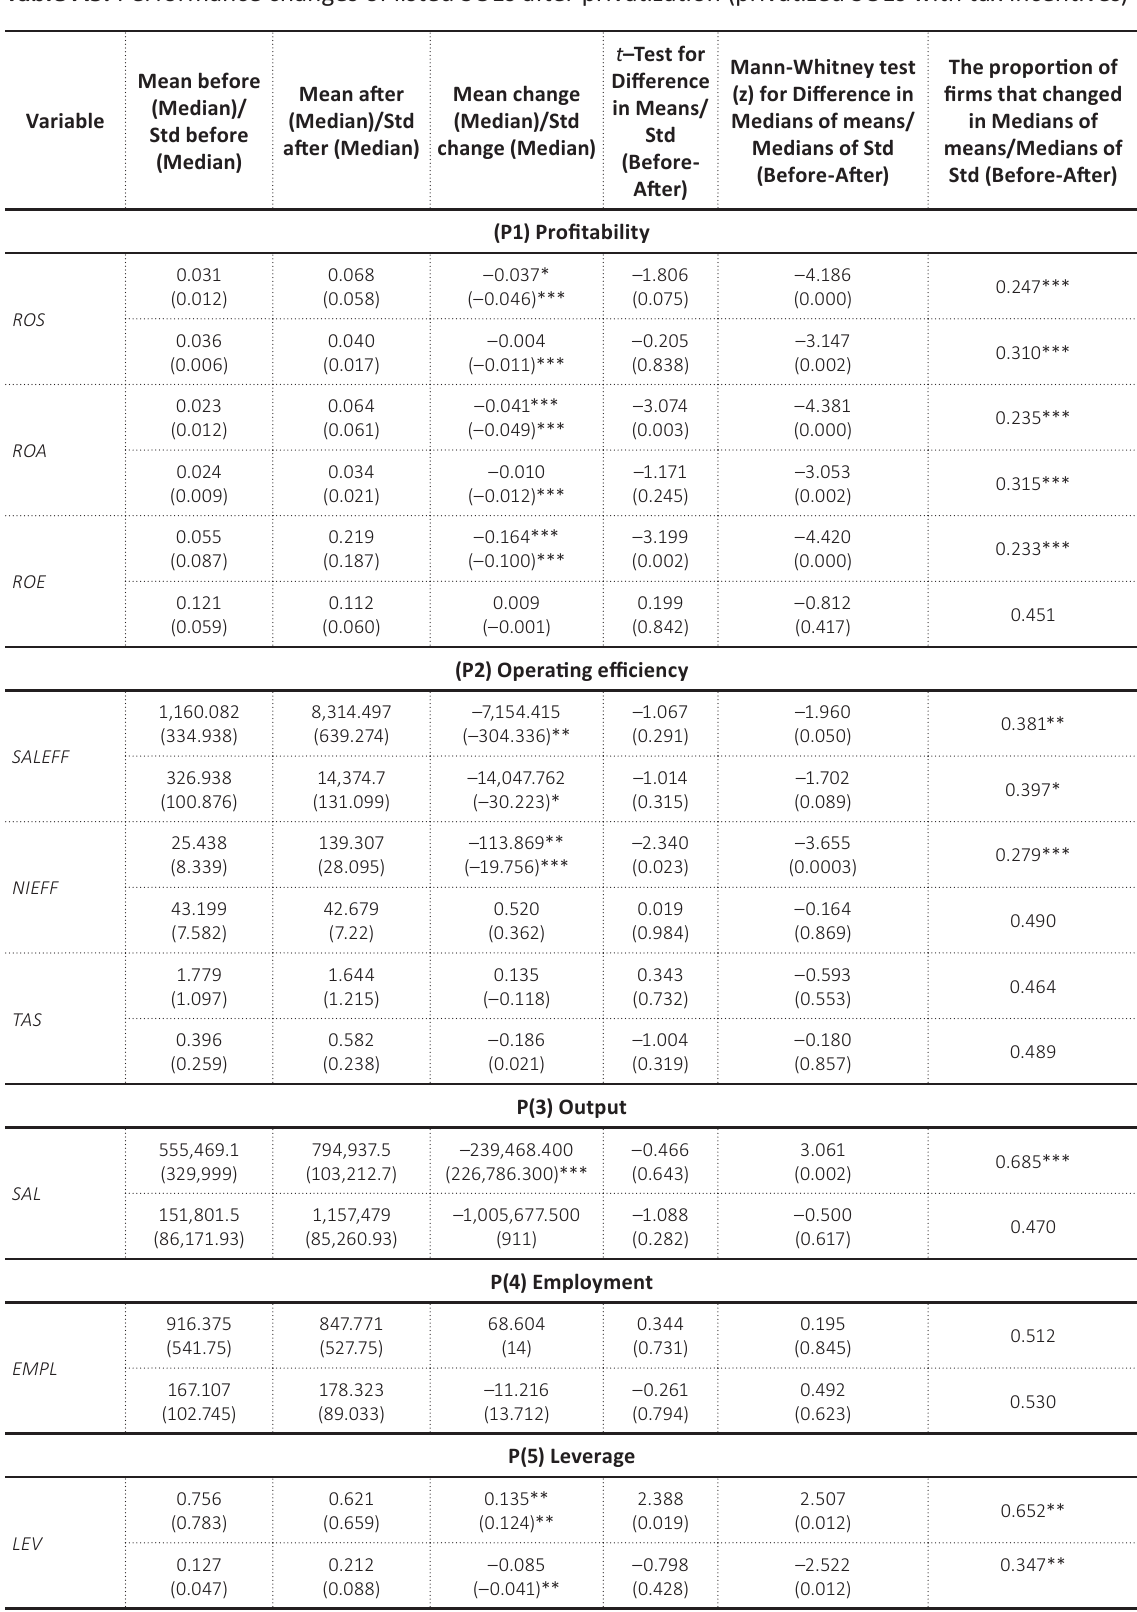
Table A5. Performance changes of listed SOEs after privatization (privatized SOEs with tax incentives)